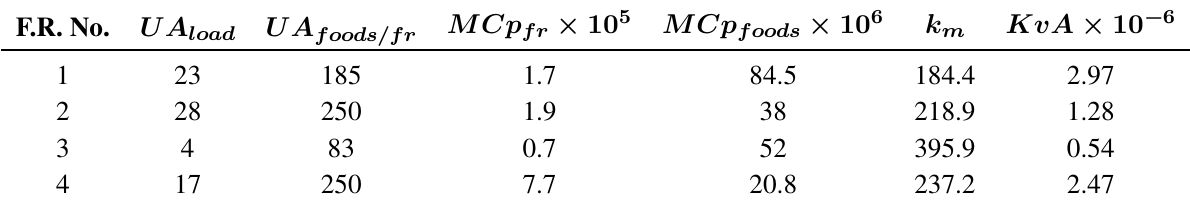
Table 3. Estimated parameters of the freezing rooms.